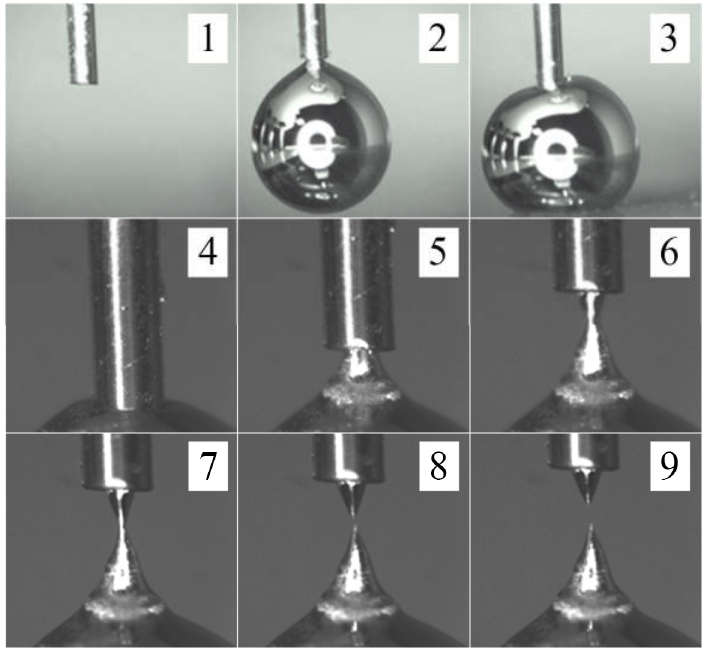
Figure 1. Formation of the EGaIn liquid eutectic